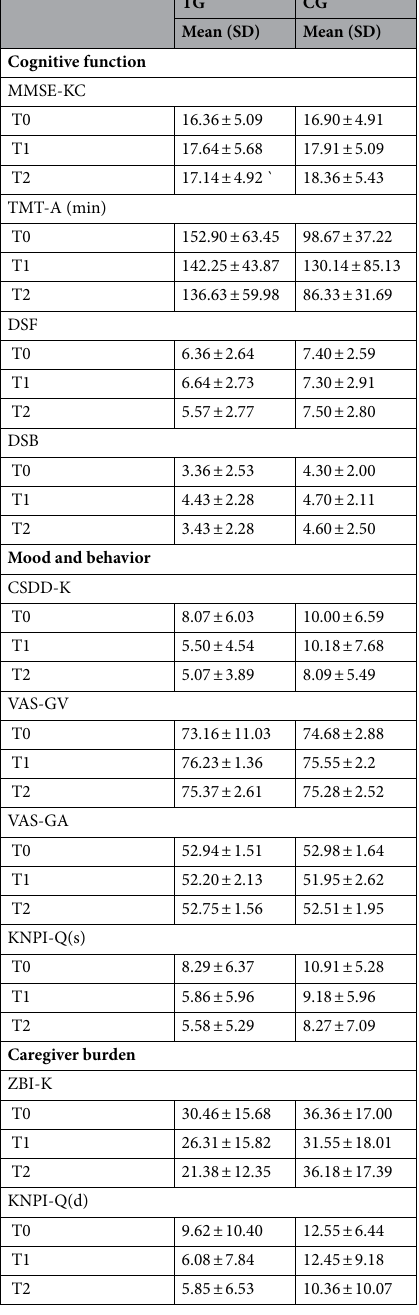
Table 3. Changes in cognition, mood and behavior across three time points in the TG (N = 14) and CG (N = 11). T0 baseline, T1 immediate post-treatment, T2 4 weeks after the end of the 2 weeks of light treatment, MMSE-KC MMSE in the Korean version of CERAD Packet, TMT-A trail making test-A, DSF digit span test forward, DSB digit span test backward, CSDD-K Korean version of the Cornell Scale for Depression in Dementia, VAS-GV visual analogue scale for global vigor, VAS-GA visual analogue scale for global affect, KNPI-Q(s) Korean Version of the Neuropsychiatric Inventory Questionnaire (severity), ZBI-K Korean version of Zarit Burden Interview, KNPI-Q(d) Korean Version of the Neuropsychiatric Inventory Questionnaire